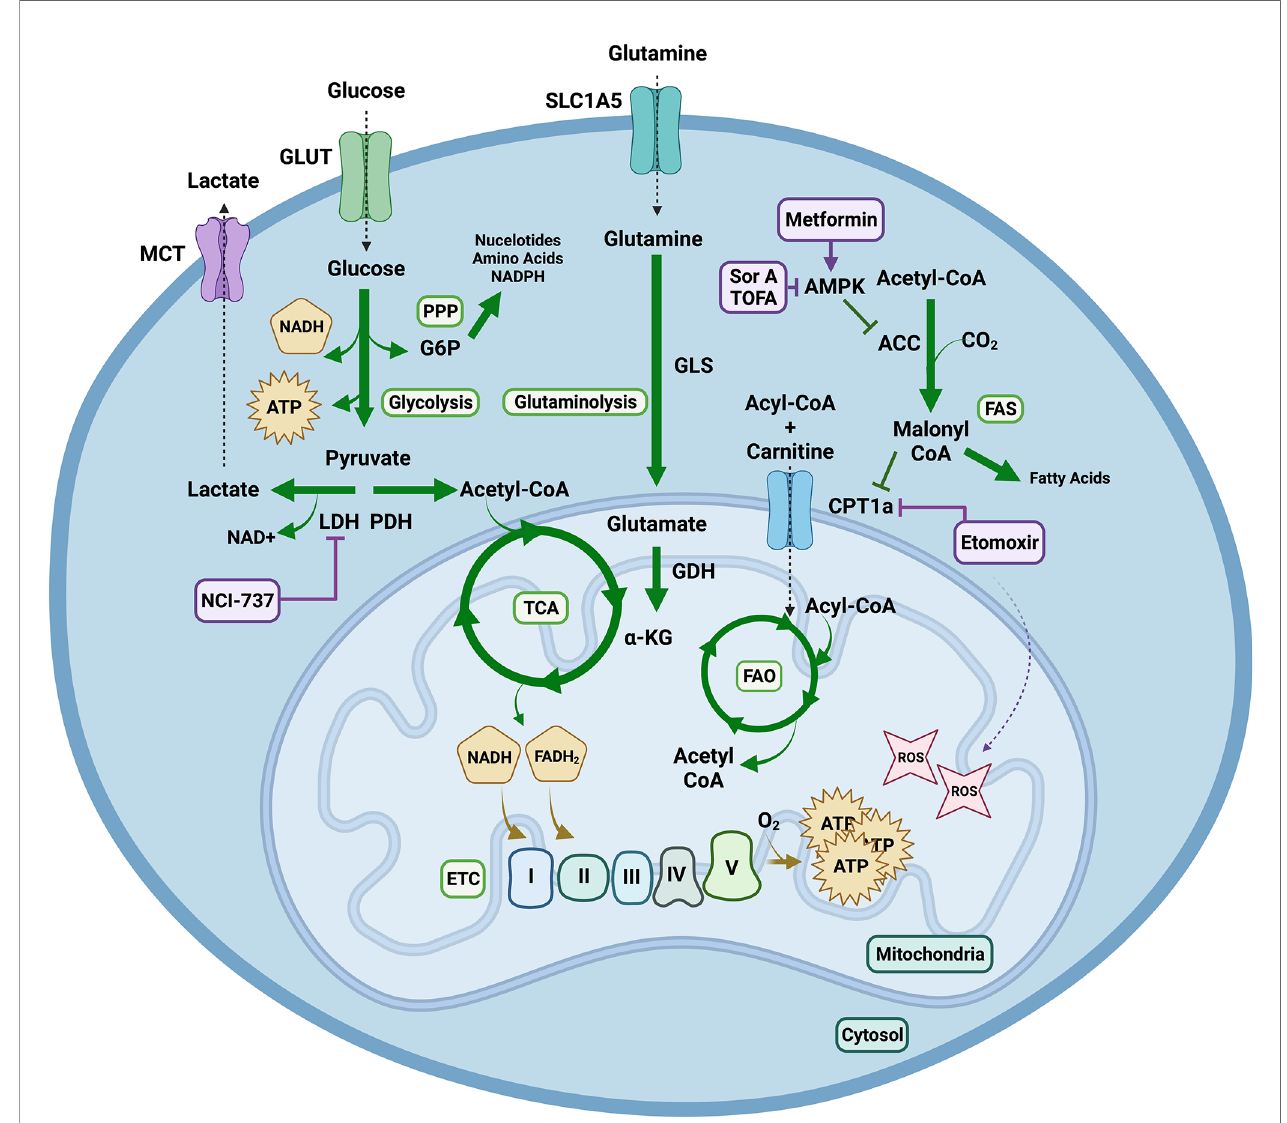
FIGURE 3 | Metabolic Pathways Contributing to Graft Versus Host Disease. Extracellular glucose is transported into the cell and utilized to generate two molecules of pyruvate and ATP in glycolysis. Pyruvate has multiple fates. It can be converted into lactate via lactate dehydrogenase (LDH) replenishing nicotinamide adenine dinucleotide (NAD) + for glycolysis. This can be exploited by highly proliferative cells to continuously produce ATP via glycolysis, even in the presence of O 2 , in a process known as aerobic glycolysis or the Warburg effect. Lactate can be exported from the cell through monocarboxylic transporters (MCT). Alternatively, pyruvate can be decarboxylated into acetyl-CoA via pyruvate dehydrogenase (PDH) to enter the tricarboxylic acid (TCA) cycle. One turn of the TCA cycle yields GTP, CO 2 and reduced forms of nicotinamide adenine dinucleotide hydrogen (NADH) and fl avin adenine dinucleotide (FADH 2 ); which can shuttle electrons into the mitochondrial electron transport chain (ETC) where O 2 serves as the fi nal electron acceptor to generate high amounts of ATP in a process known as oxidative phosphorylation (OXPHOS). OXPHOS can mediate production of reactive oxygen species (ROS) such as superoxide. During glutaminolysis glutamine is hydrolyzed into glutamate, which can be converted by glutamate dehydrogenase (GDH) into alpha ketoglutarate ( a -KG) in order to enter the TCA cycle. Additionally, fatty acids (FA) undergo beta oxidation in the mitochondrial matrix to produce acetyl-CoA and electron carriers. The formation of malonyl-CoA from acetyl-CoA by acetyl-CoA carboxylase (ACC) early in fatty acid synthesis (FAS), inhibits carnitine palmitoyltransferase (CPT1a), the rate limiting step of fatty acid oxidation (FAO), strictly controlling the processes of FAS and FAO. Lastly, the nuclear energy sensor 5 ’ -AMP-activated protein kinase (AMPK) can inhibit ACC releasing inhibition of CPT1a thus indirectly promoting FAO. Pharmacological agents targeting these metabolic pathways include NCI-737 inhibiting LDHA, metformin activating AMPK, soraphen A and 5-(Tetradecyloxy)-2-furoic acid (TOFA) inhibiting ACC and etomoxir inhibiting CPT1a. Notably concentrations of etomoxir above 5uM have been shown to induce ROS production. Created with